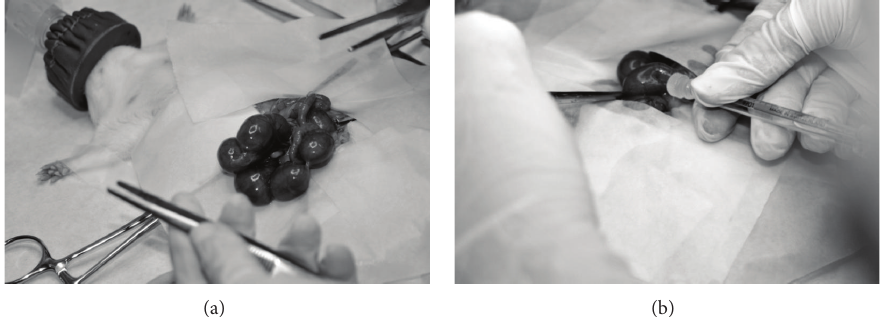
Figure 2: Pictures taken during transplantation. (a) A uterine horn can be observed; in this step, the disposition of the fetuses in the uterus was visualized. (b) The place where the intraperitoneal injection to a fetus in utero was made is